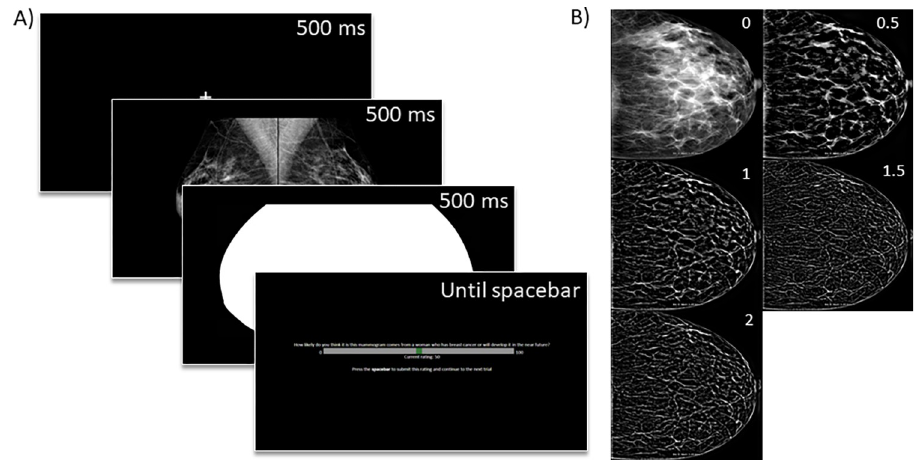
Fig 1. Procedure and stimuli used in the experiment. (A) Example visualization of the different screens in one trial, showing the fixation cross, mammogram case, mask, and rating screen. (B) Examples for the unaltered (0) and high- pass filtered versions (0.5, 1, 1.5, and 2 cpd) of a unilateral